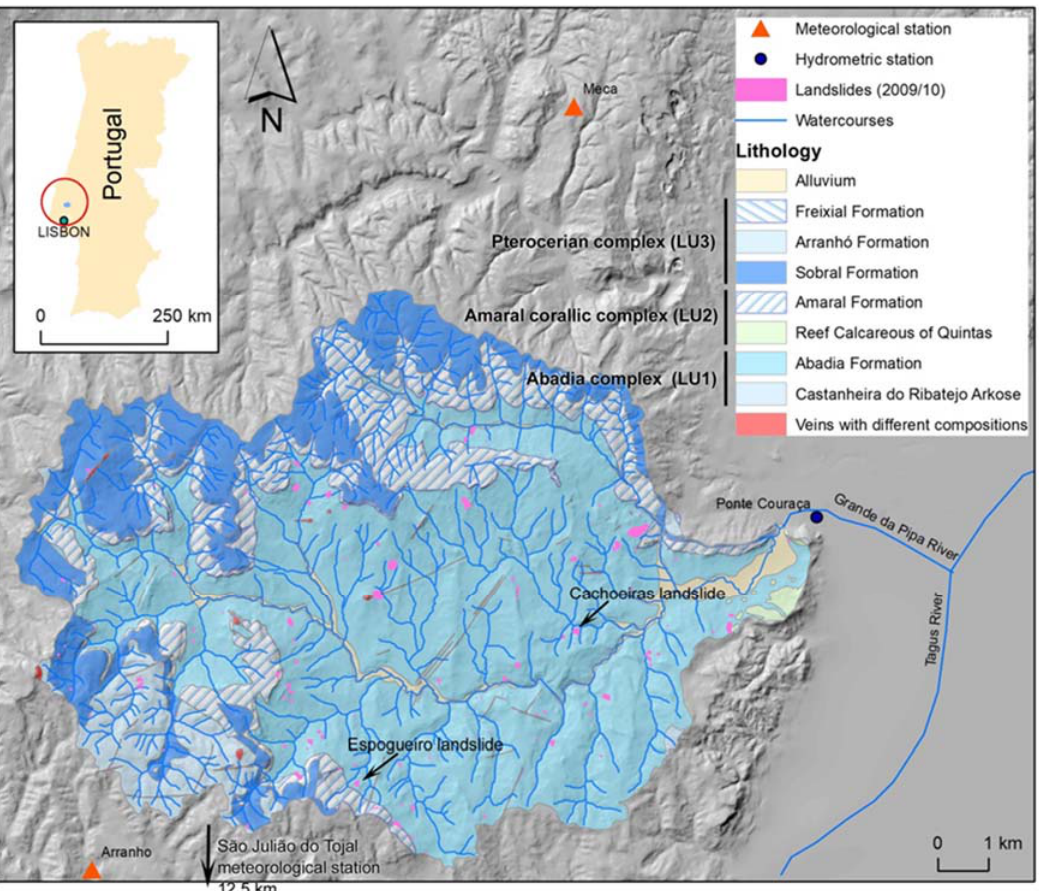
Figure 1. Geology of the Grande da Pipa River (GPR) basin and landslides inventory.